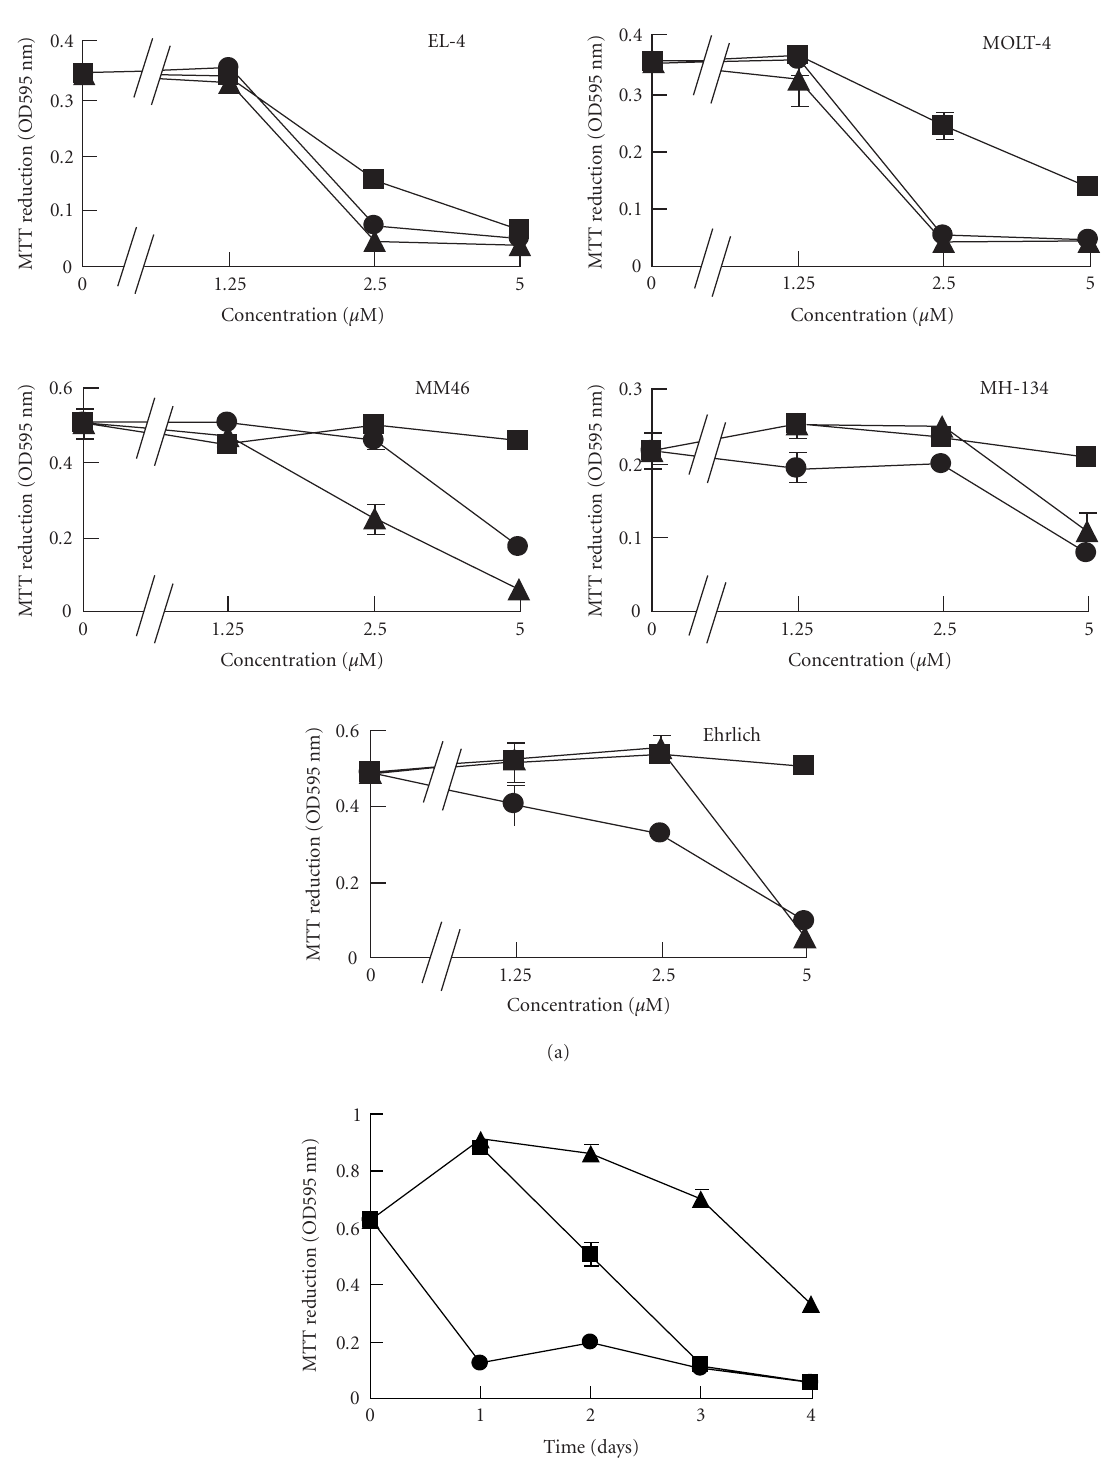
Figure 1. Cell death-inducing activity of recombinant human S100A8/A9 complex, DTPA and TPEN against various cell lines. (a) • ), DTPA ( (cid:1) ), or TPEN ( (cid:2) ) for 24 h (MM46 cells, MH-134 cells, and Ehrlich The indicated cell lines were cultured with S100A8/A9 ( cells) or 40h (EL-4 cells and MOLT-4 cells). (b) Kinetics of induction of MM46 cell death by S100A8/A9 and DTPA. MM46 cells were • cultured without ( (cid:2) ) or with 10 µ M S100A8/A9 ( ) or 10 µ M DTPA ( (cid:1) ) for the indicated periods. The viability of each cell line was evaluated by MTT assay. Bars represent standard